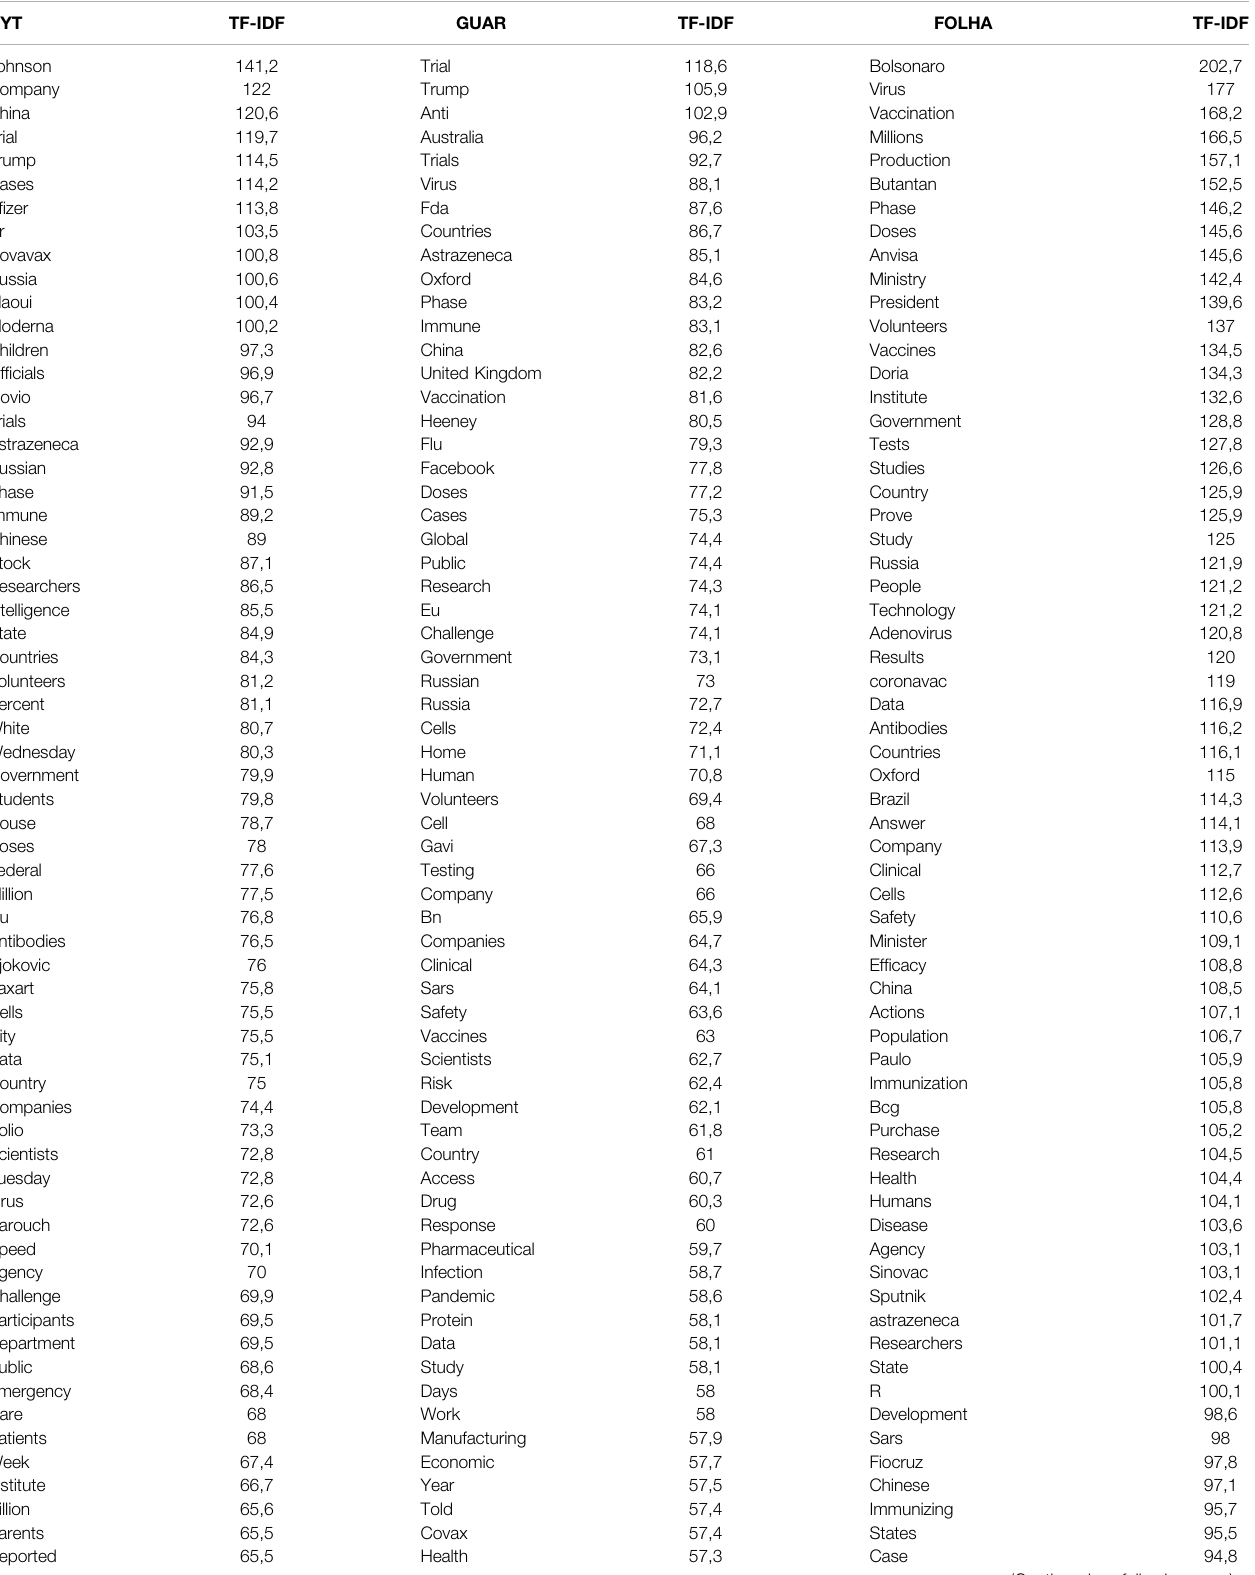
TABLE 1 | Most frequent words in the body texts of The New York Times , The Guardian , and Folha de São Paulo , arranged by the TF-IDF value. NYT